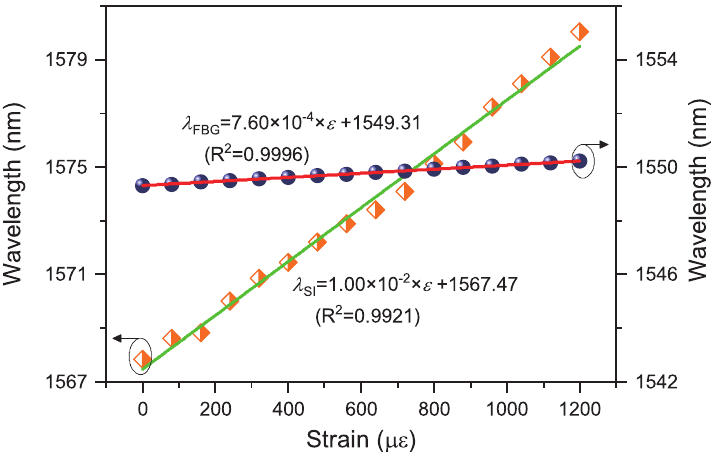
Figure 7. Axial-strain responses of Sagnac interference dip (orange square with green line) and Bragg peak of fast-axis polarized mode (blue sphere with red